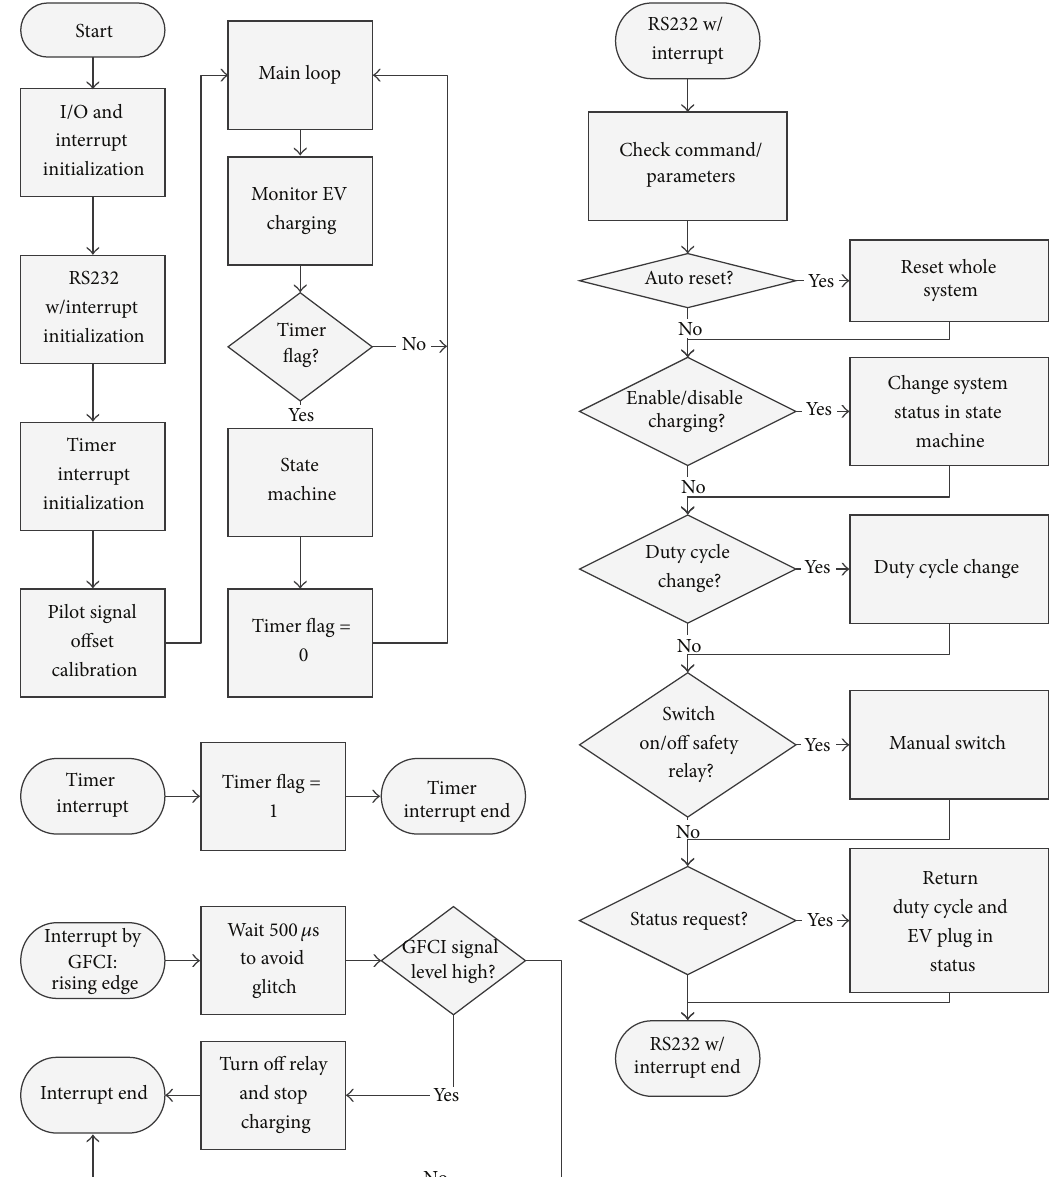
Figure 13: Local controller firmware flow